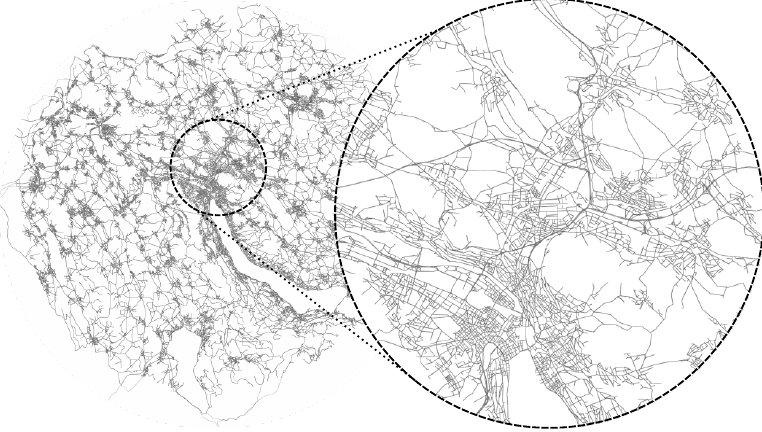
Figure 5. Road network of the metropolitan area of